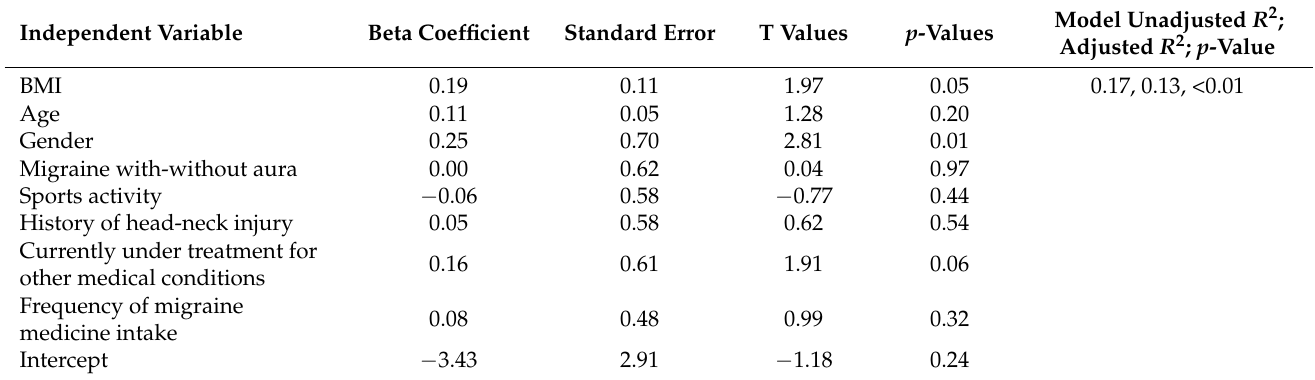
Table 2. Multiple regression predictors of the insomnia symptoms severity level in migraine patients with/without